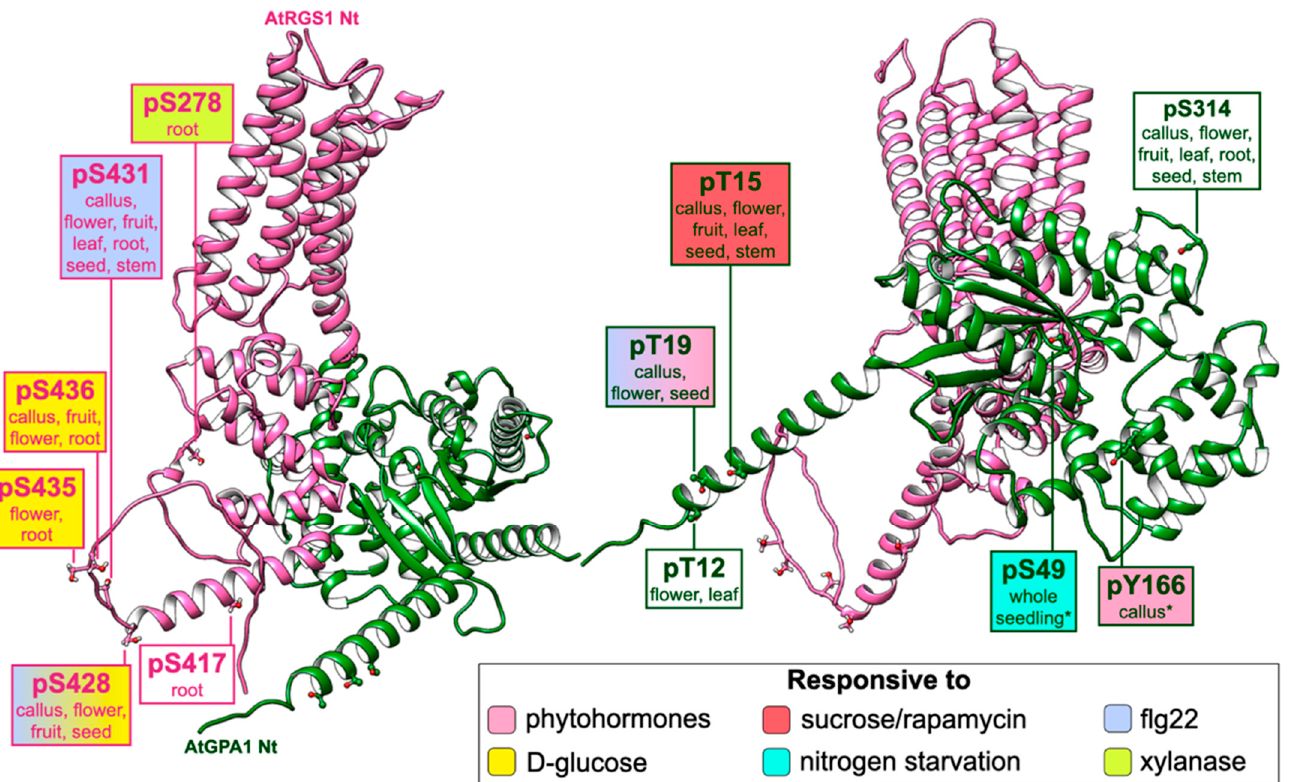
Figure 2. Experimental phosphorylation map of AtRGS1 and AtGPA1 dimer. Structural models of AtRGS1 (hot pink) and AtGPA1 (forest green) are shown. Xylanase-induced phosphorylation is detected at serine 278, which constitutes the linker region of AtRGS1 [25,26]. Phosphorylation occurs at the C-terminal tail of AtRGS1 in the serine residues 417, 428, 430, 431, 435, and 436 [26]. D -glucose-induced phosphorylation of AtRGS1 occurs at Ser428/435/436 [14], and phosphorylation under flg22 treatment is Ser428/431-dependent [27]. AtGPA1 is phosphorylated at the N-terminal threonine residues 12, 15, and 19 [26,28–32]. pThr19 has a reduced phosphorylation signal with flg22 treatment but is induced by ABA. Tyrosine residue 166 is at the all-alpha helical domain interface and responds to several phytohormones [29,33]. Phosphorylation occurs at the catalytic domain of the serine residues 49 and 314, and pSer49 is induced by sugar exposure [26,29,34]. Top-ranked models